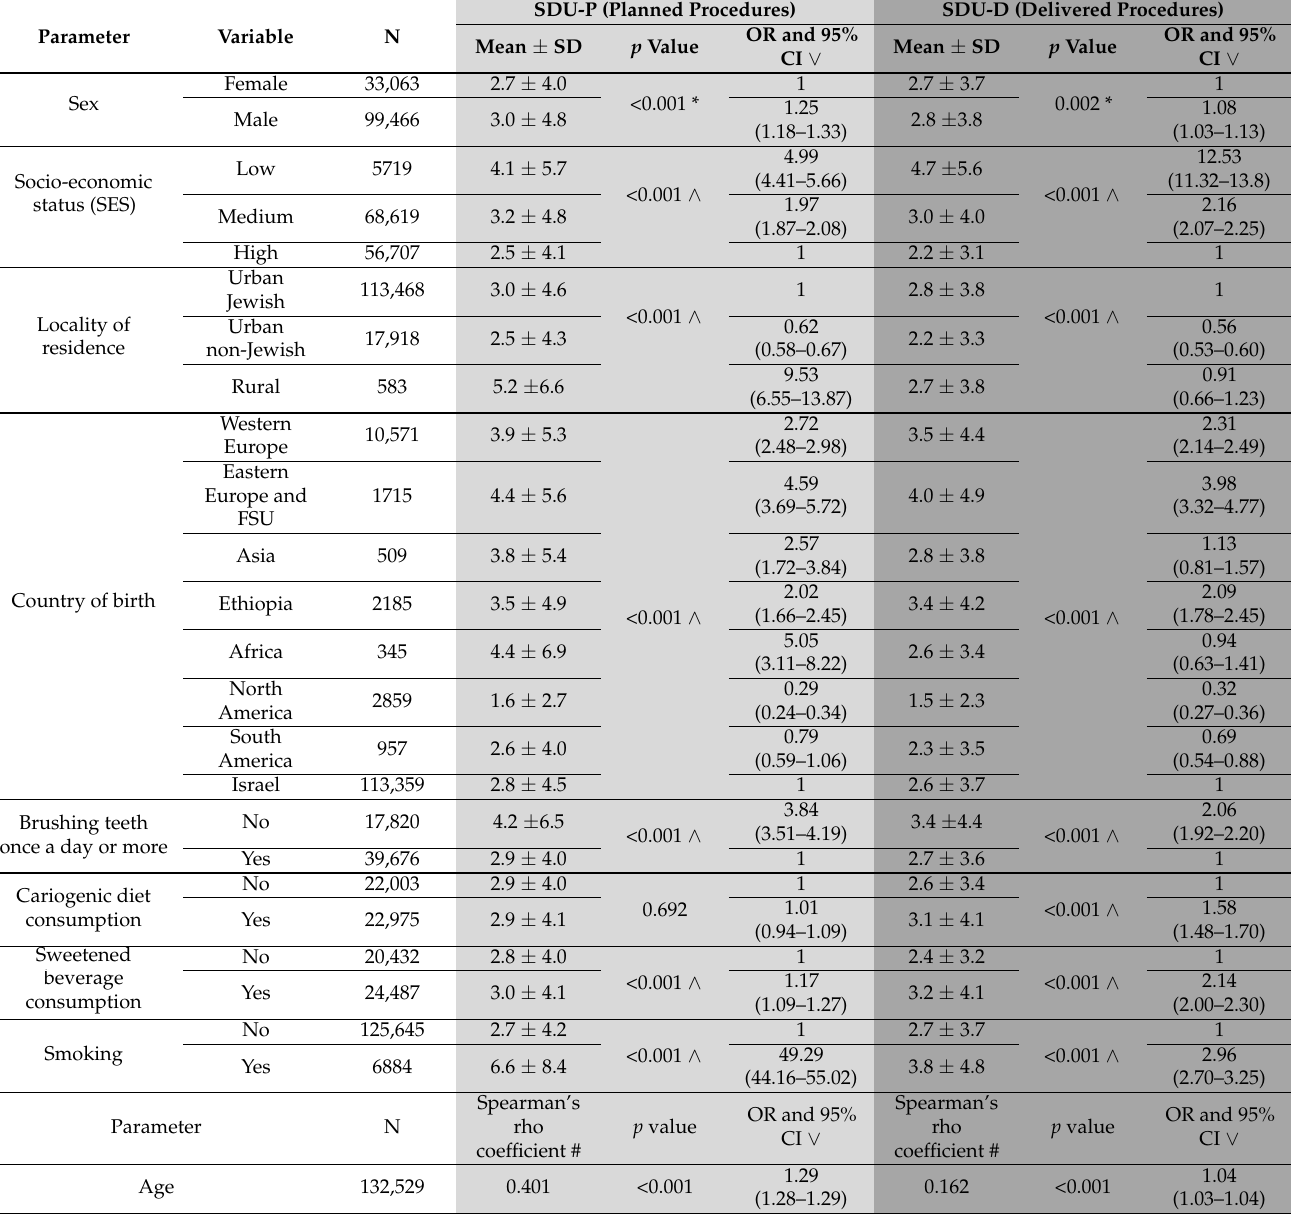
Table 2. The associations of SDU-P (planned procedures) and SDU-D (delivered procedures) with socio-demographic and health-related risk factors. # Spearman’s correlation, * non-paired t -test, ∧ ANOVA, ∨ general linear model, FSU: former Soviet